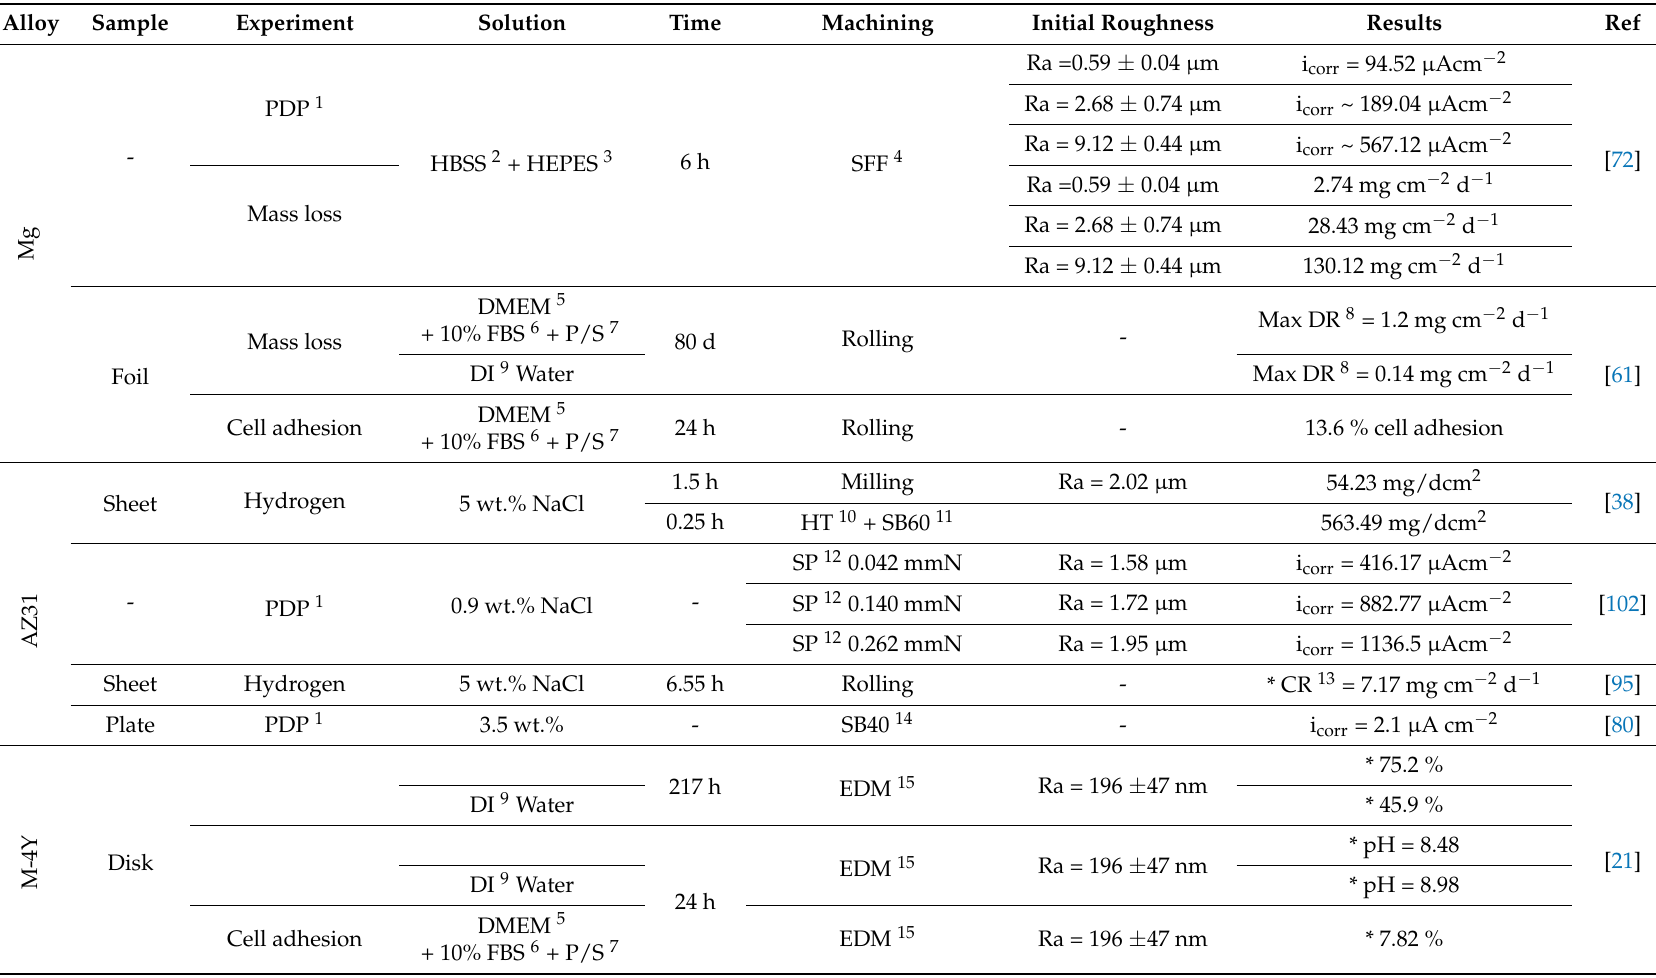
Table 2. Overview of different studies investigating SFF and machining and their influence on the degradation behavior. * Values were determined from the diagram with the corresponding